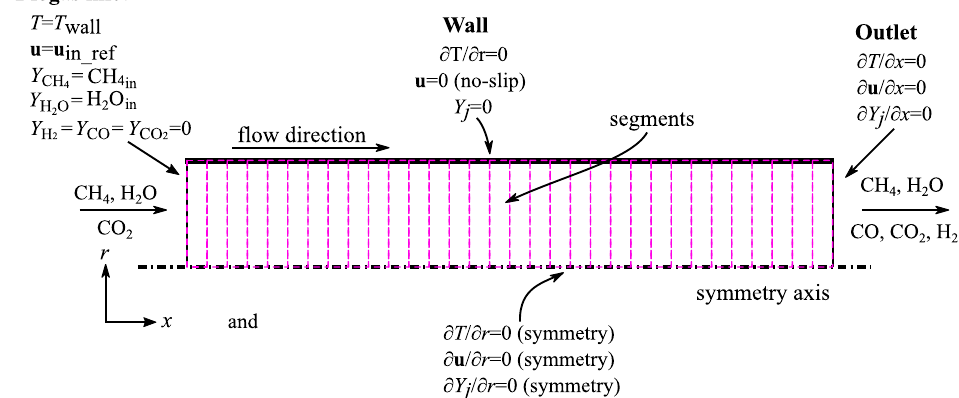
Figure 2. The boundary conditions applied in the analysis of biogas